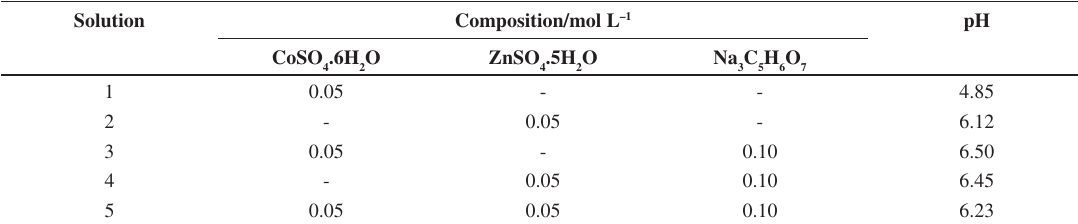
Table 1. Chemical composition and pH values of the studied solutions. Solution